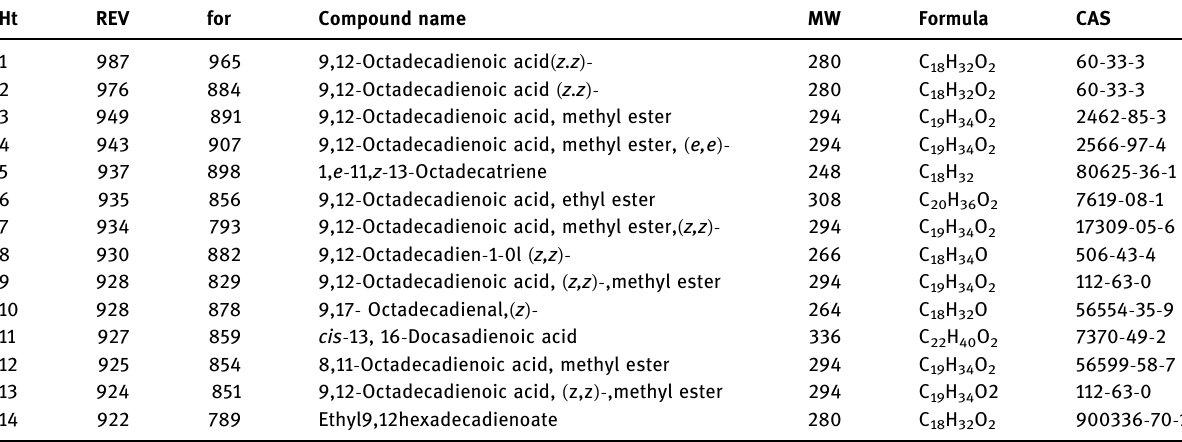
Table 1: Main compounds identi fi ed by GC – MS analysis in the Z. mays silk extract